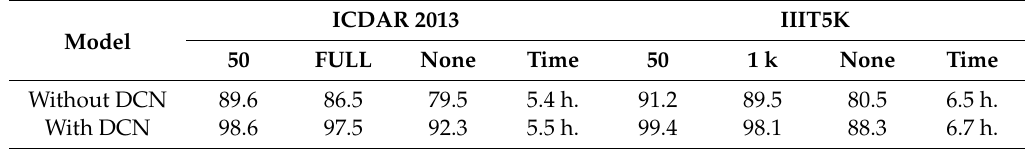
Table 5. Recognition accuracies (%) of dense connection network and its ablation study.